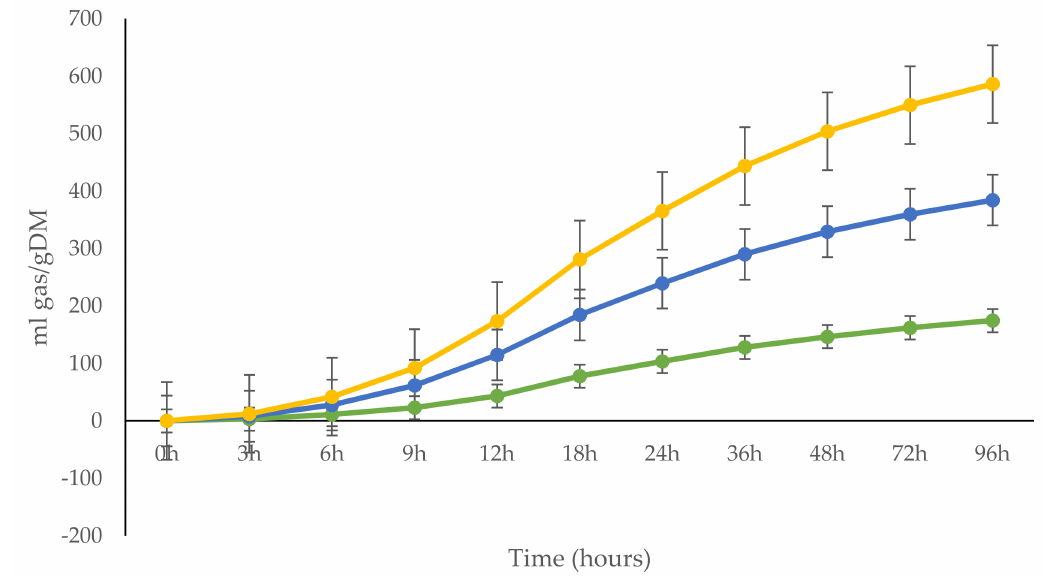
Figure 1. Total gas production (mL gas / g DM) over 96 h of in vitro incubation from calcium soaps of palm oil (yellow line), sa ffl ower oil (blue line) and canola oil (green